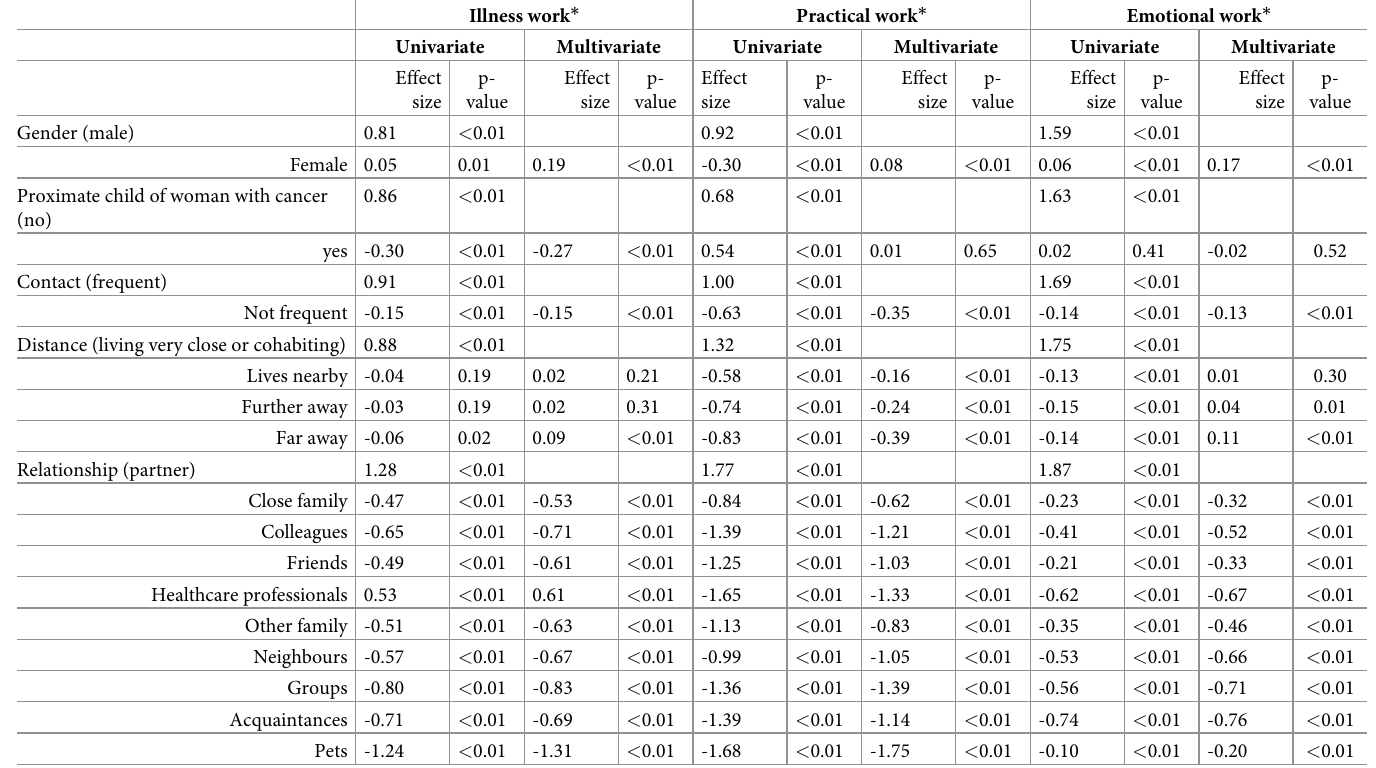
Table 4. Univariate and multivariate regressions–network member